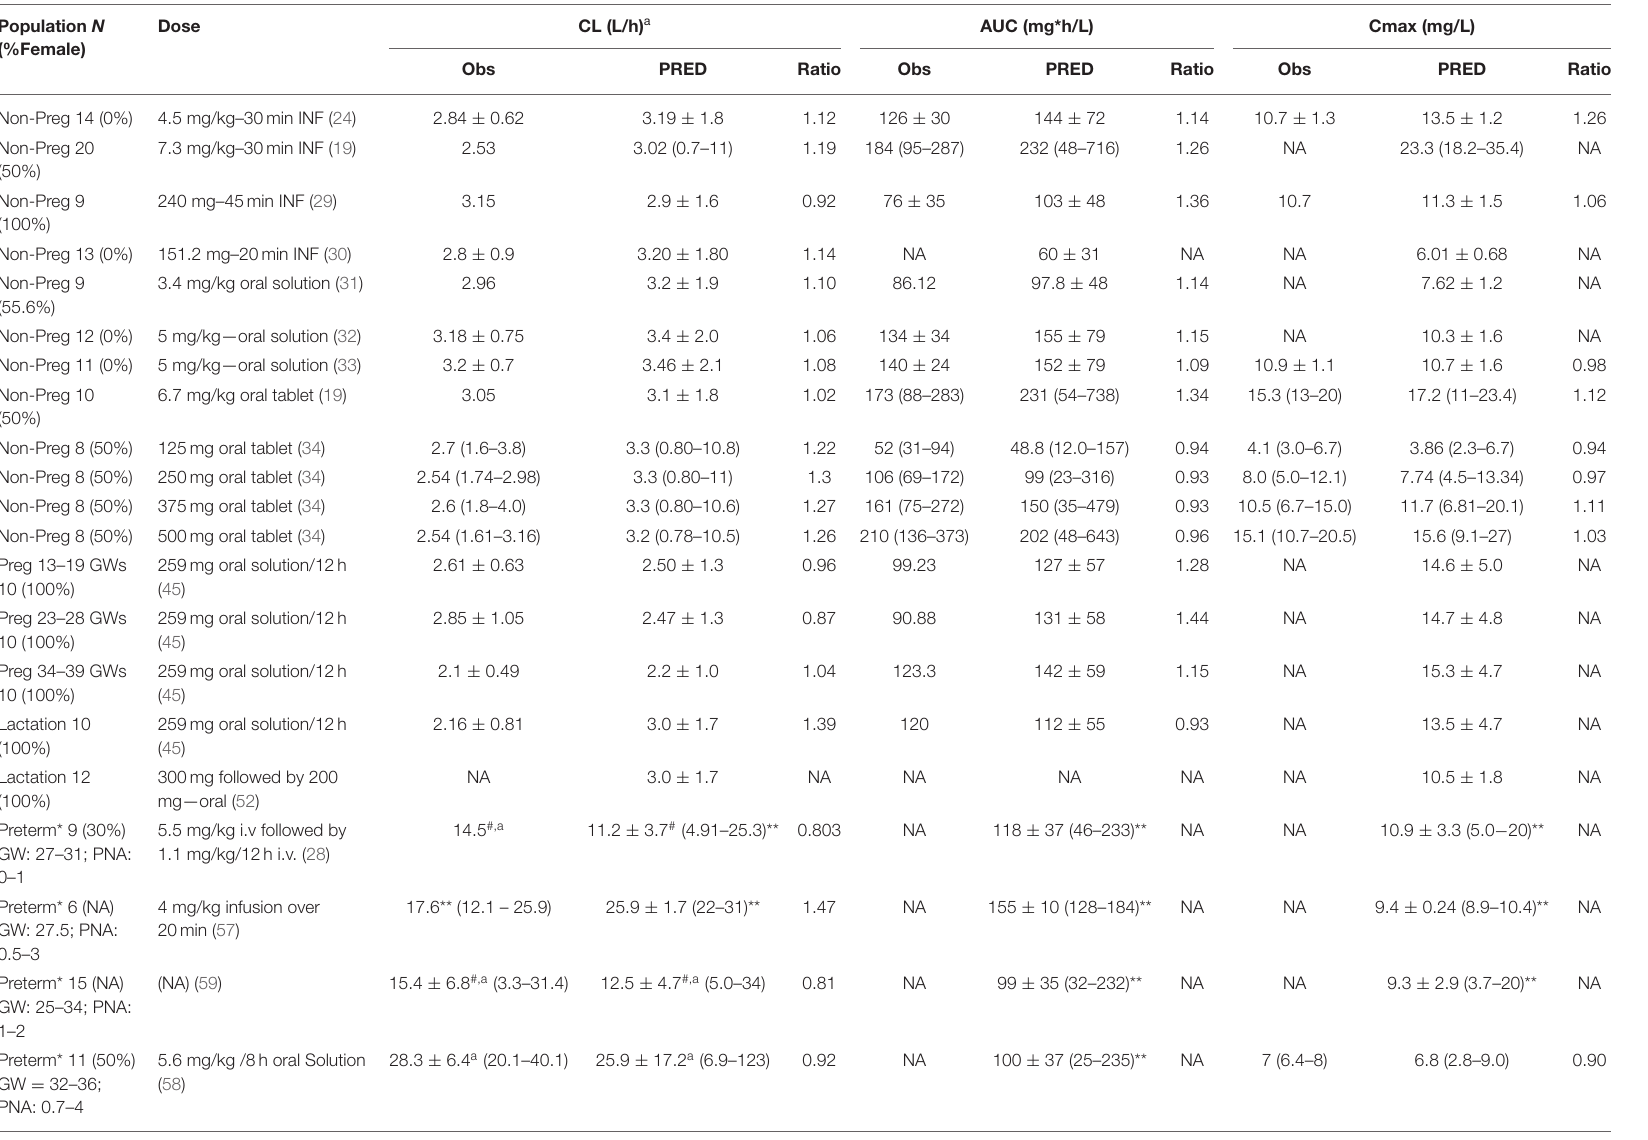
TABLE 1 | Predicted vs. observed theophylline pharmacokinetics (PK) parameters in pre-pregnant, pregnant, breastfeeding, and neonatal populations. Population N